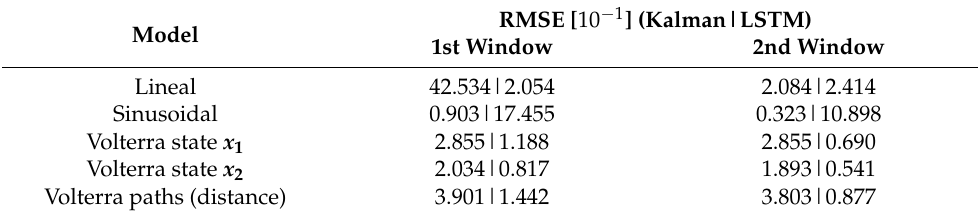
Table 8. The RMSE with measurement loss simulation.